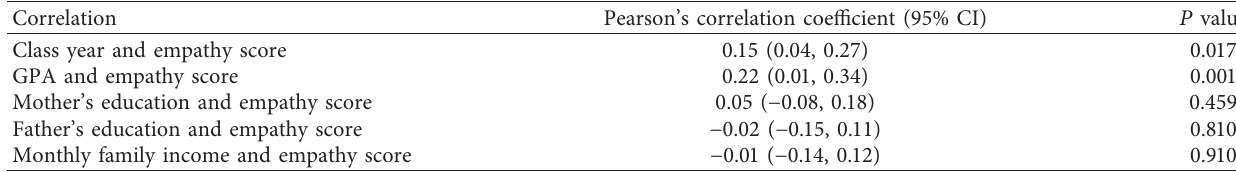
Table 3: Bivariate linear regression analyses: correlation between sociodemographic factors and empathy score in study participants. Correlation